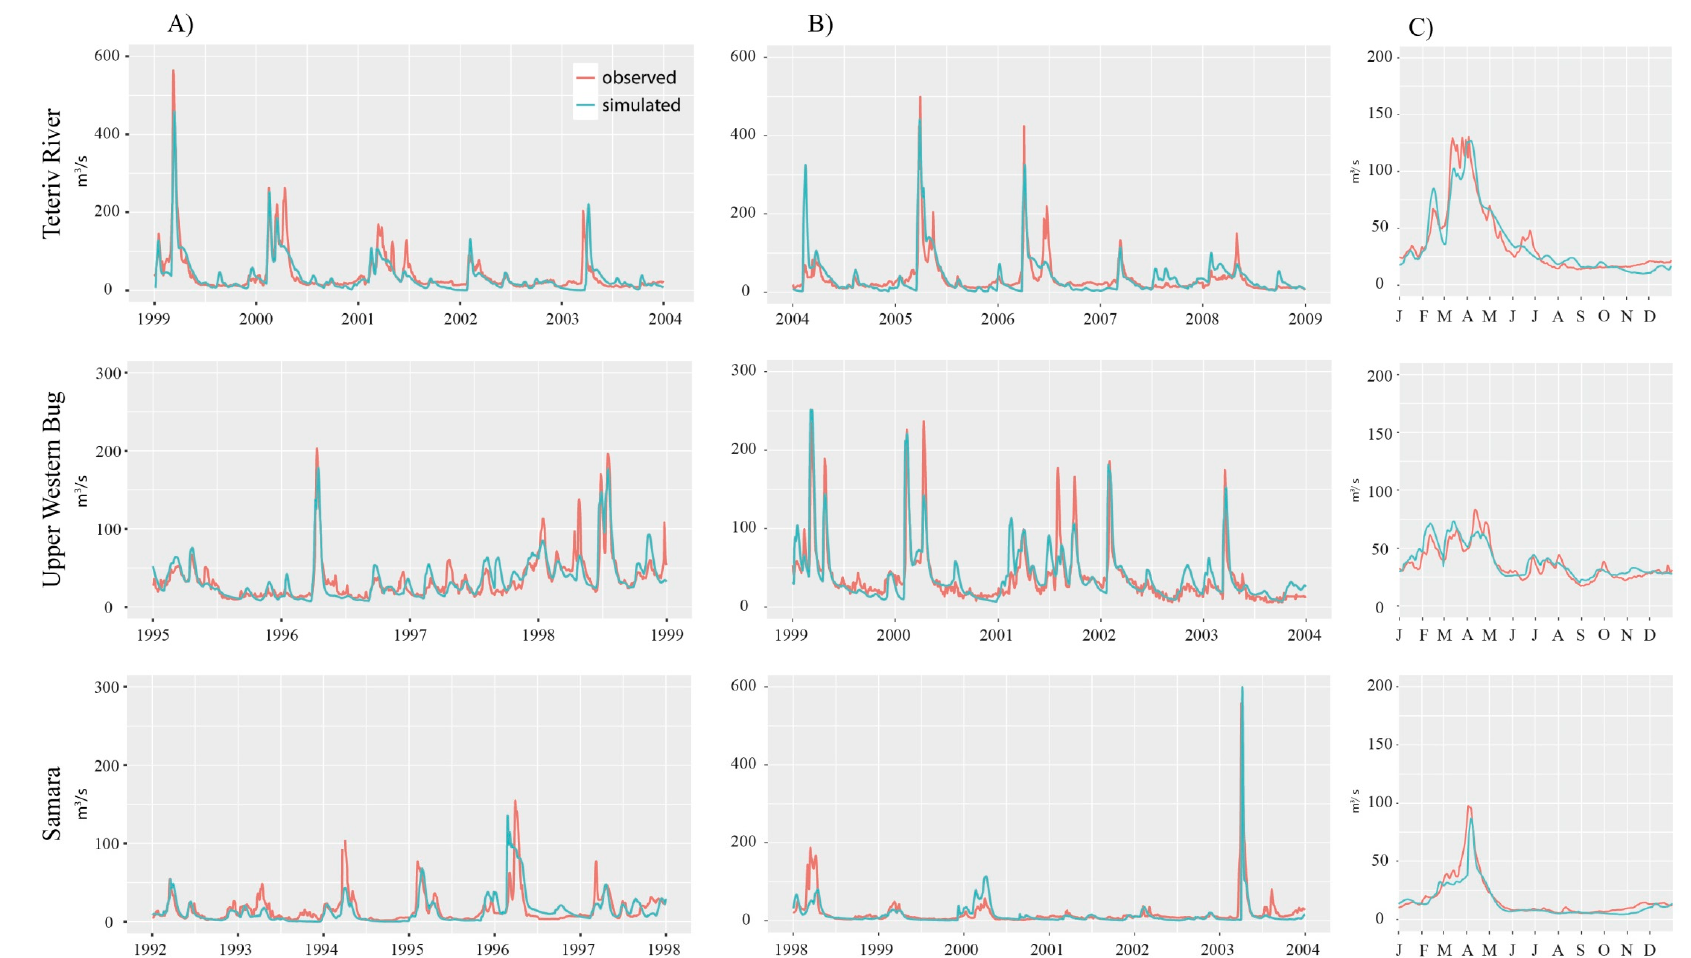
Figure 2. Calibration and validation of the model for three catchments under study. ( A ) Simulated and observed river discharge with the daily time step for the calibration period; ( B ) simulated and observed river discharge with the daily time step for the validation period; and ( C ) seasonal dynamics for both periods with the daily time step.